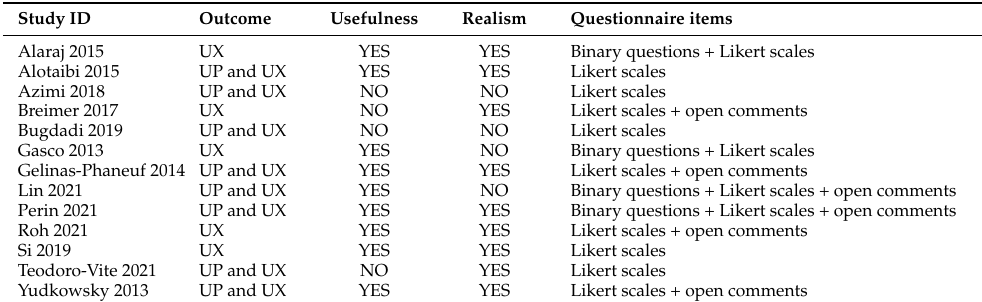
Table 4. User experience. List of studies addressing quantitative metrics of UX, along with related relevant experimental design